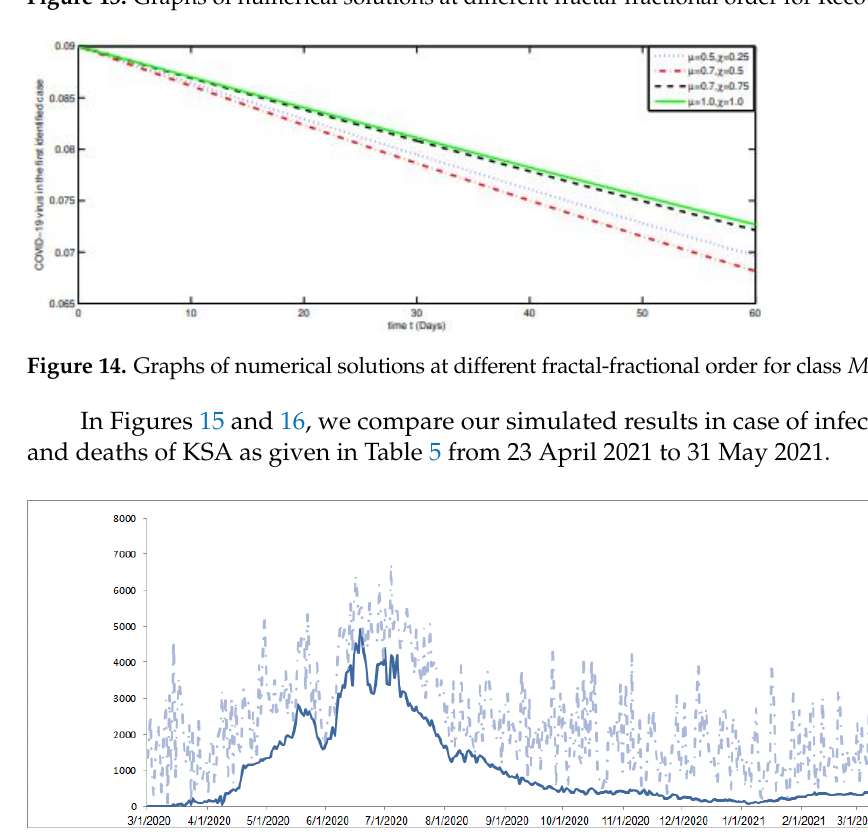
Figure 13. Graphs of numerical solutions at different fractal-fractional order for Recovered class.